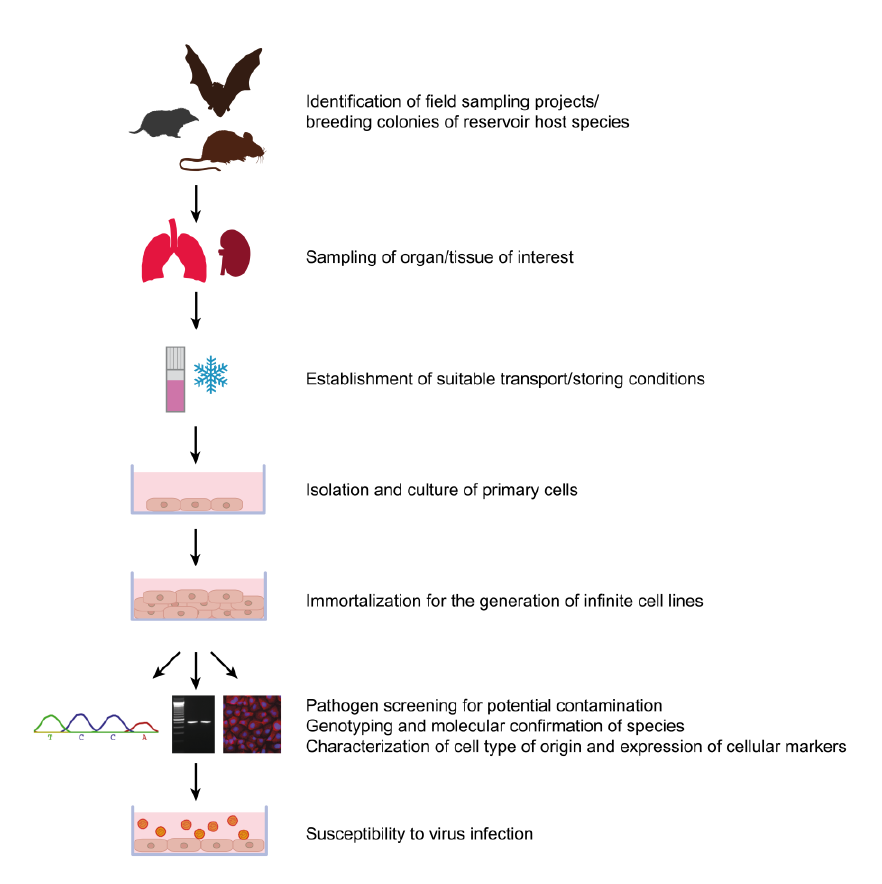
Figure 1. Algorithm for the generation of reservoir-derived cell lines from bats, insectivores and rodents. A similar approach has already been successfully applied for the establishment of bat, rodent and insectivore cell lines